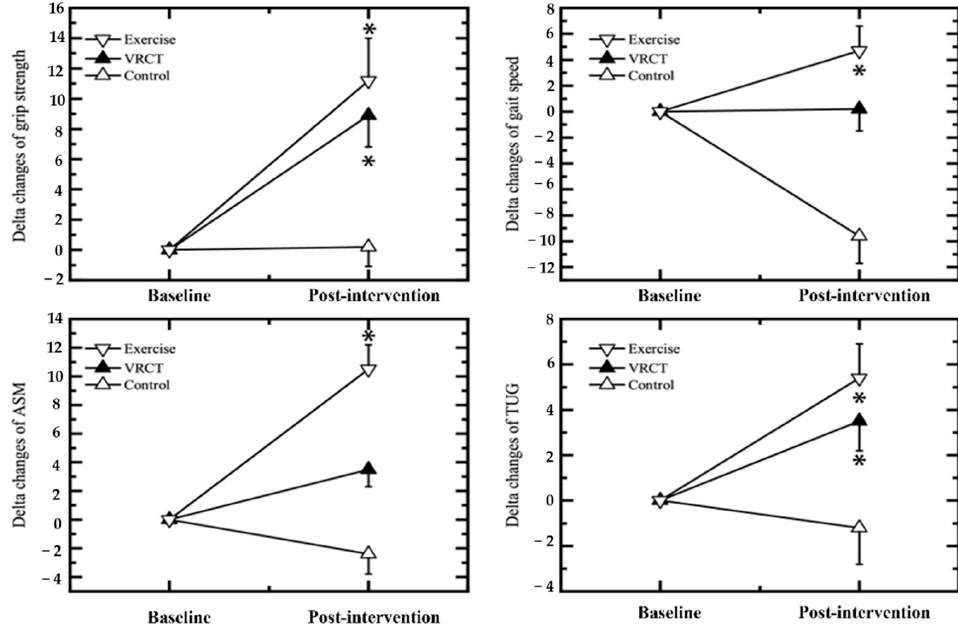
Figure 6. Percent changes in the physical functions in the VRCT, exercise and control groups between baseline and post-intervention. Values are expressed means ± SE; * indicates significant differences between the control groups (Bonferroni correction test, p < 0.05). VRCT, virtual-reality-based cognitive training; ASM, appendicular skeletal muscle; TUG, timed up-and-go test, * represents a significant difference ( p < 0.05) intervention group vs. control group.